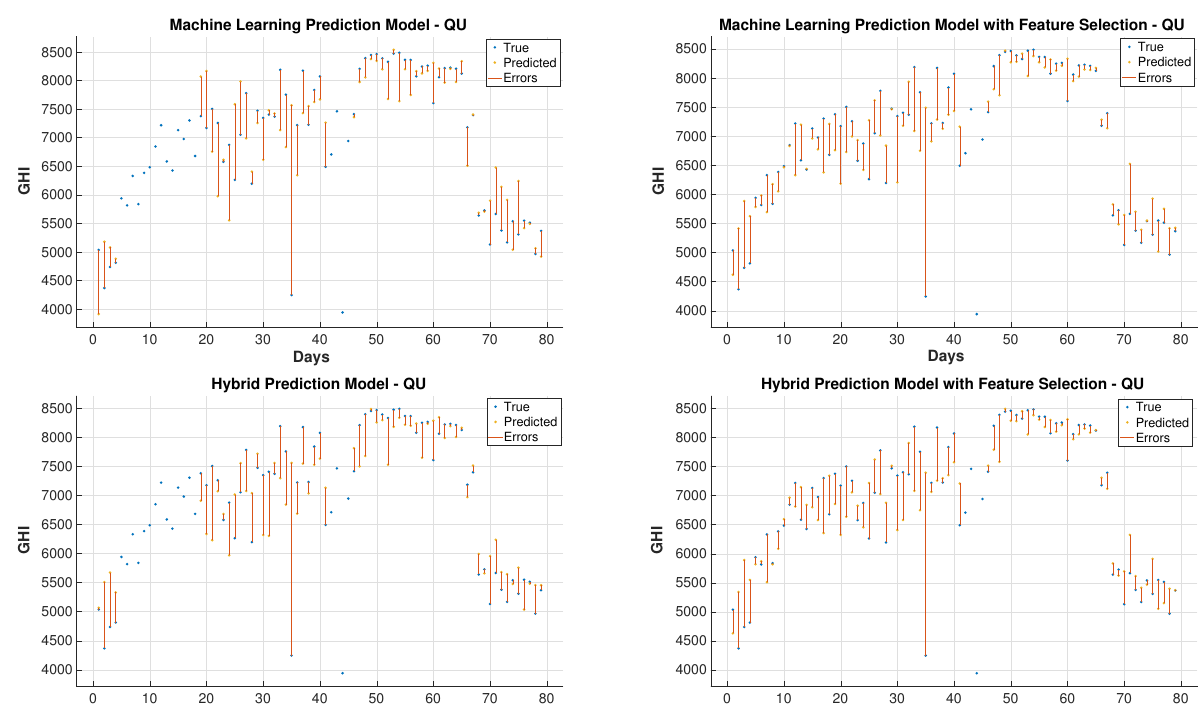
Figure 20. Prediction models for QU with the dust storm